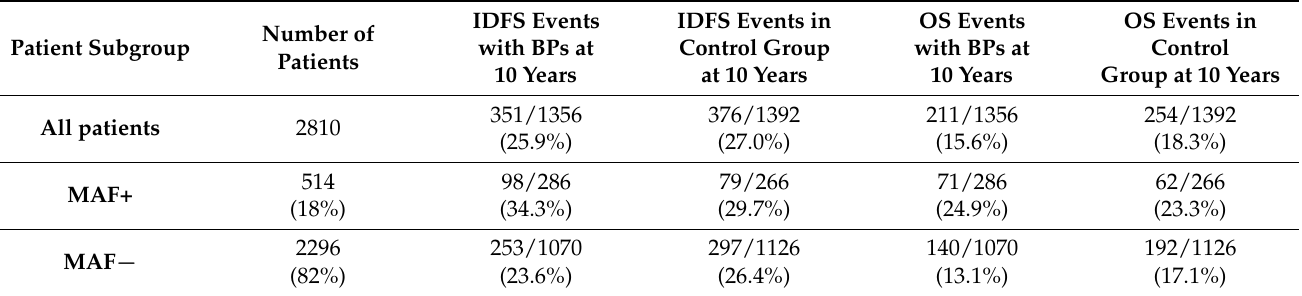
Table 1. Combined analysis of the impact of adjuvant bisphosphonates on outcomes of patients